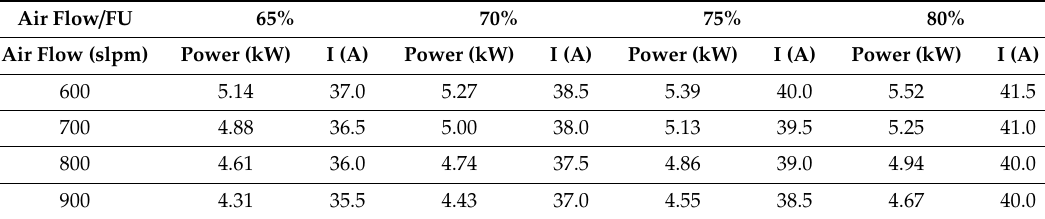
Figure 3. E ff ects of fuel use and air flow rate on the SOFC stack temperature. Table 3. E ff ects of fuel use and air flow rate on the current and gross power output of SOFC stacks under equal distribution of gases.